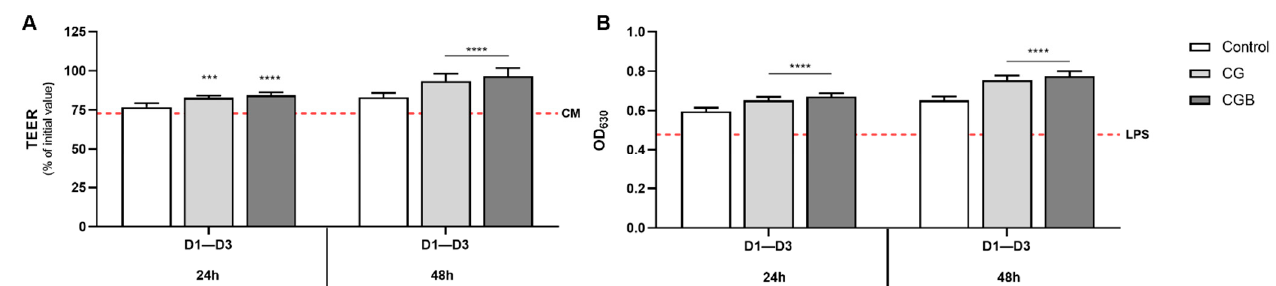
Figure 5. Effect of simulated colonic fluids exposed to CG and CGB during 24 h and 48 h on transepithelial electrical resistance ( A ) and NF- κ B activation ( B ) in a simulated colonic model. Bars represent the mean ± SEM (n = 9). Significant differences between control condition and different treatments are represented by (*** p < 0.001) and (**** p < 0.0001). CM = cell culture media (negative control); LPS = lipopolysaccharide (positive control).